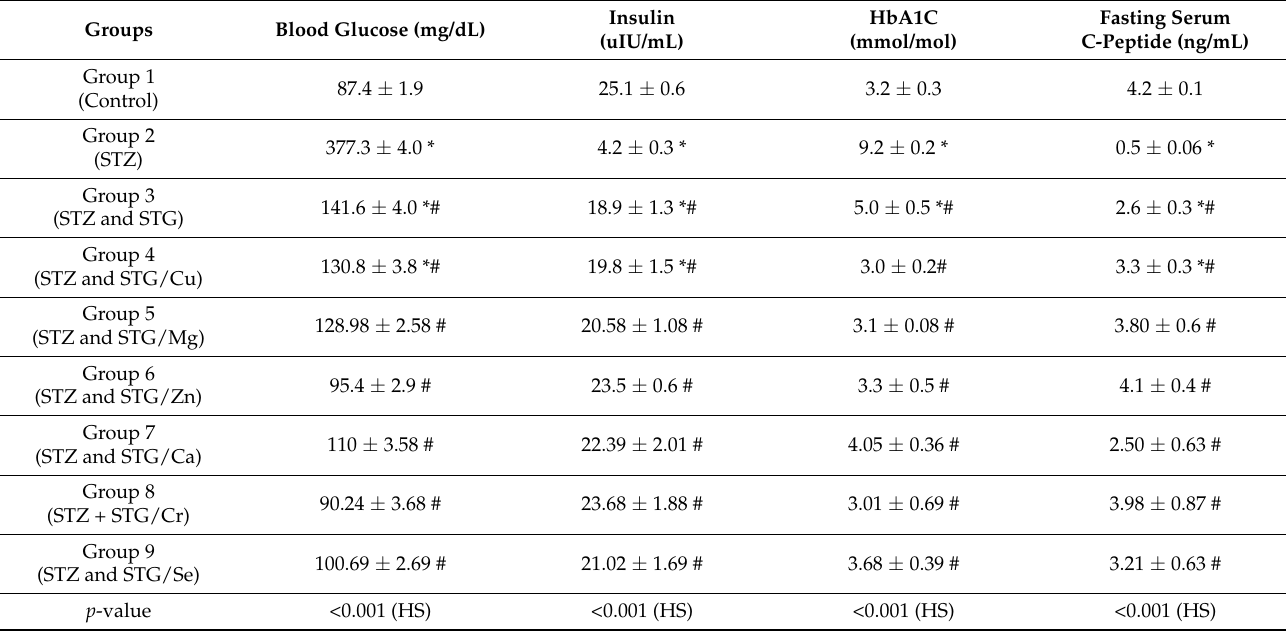
Table 4. Comparison of the studied groups in blood glucose, insulin, HbA1C, and fasting serum C-peptide